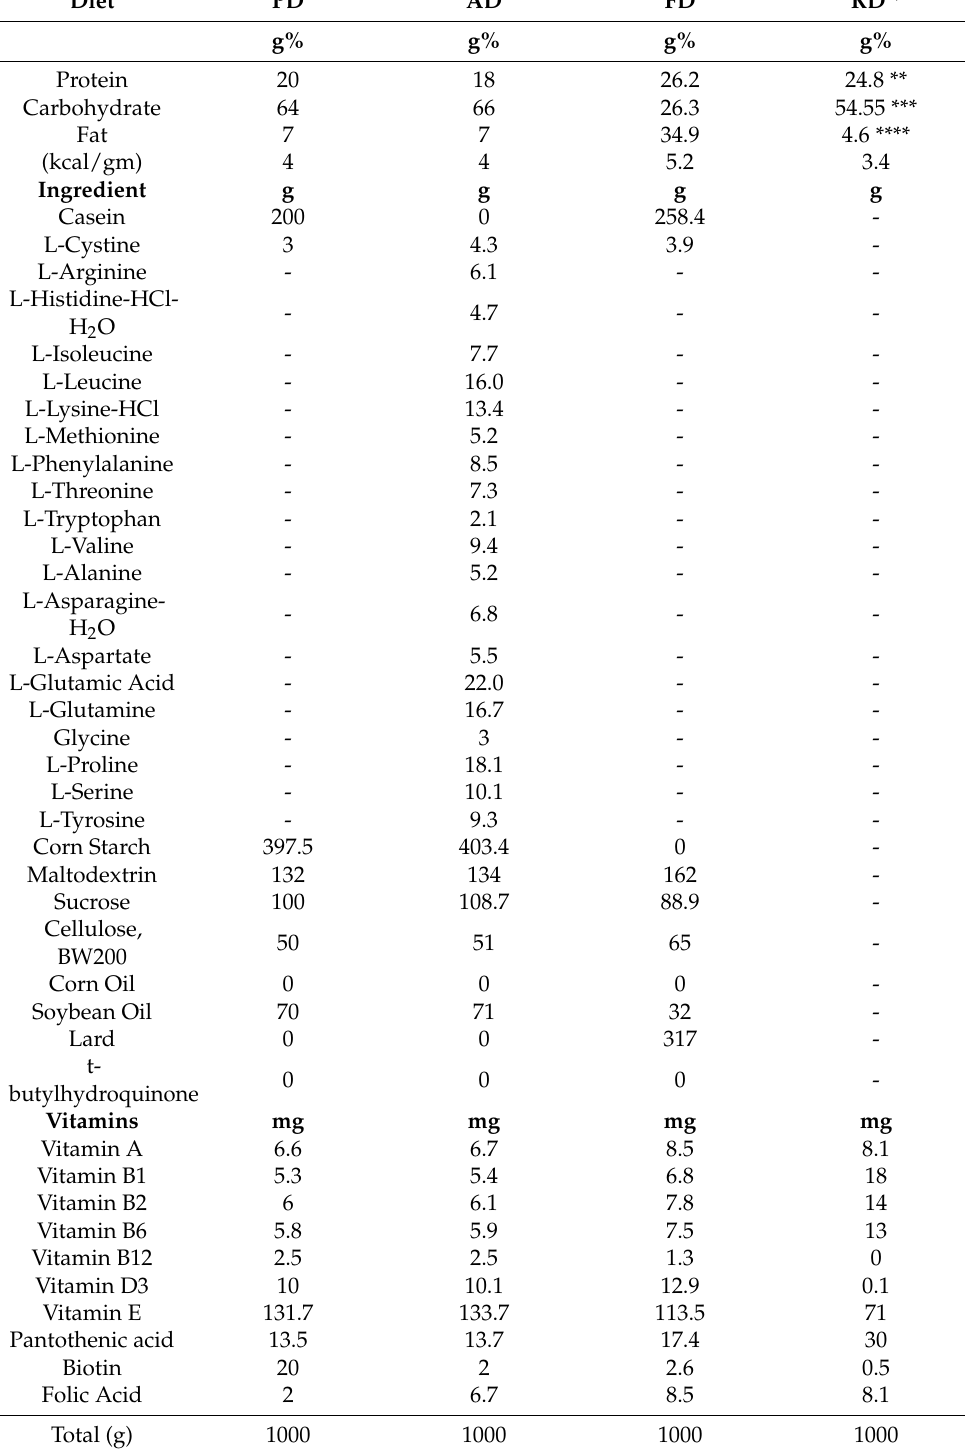
Table 1. Nutrient composition of experimental